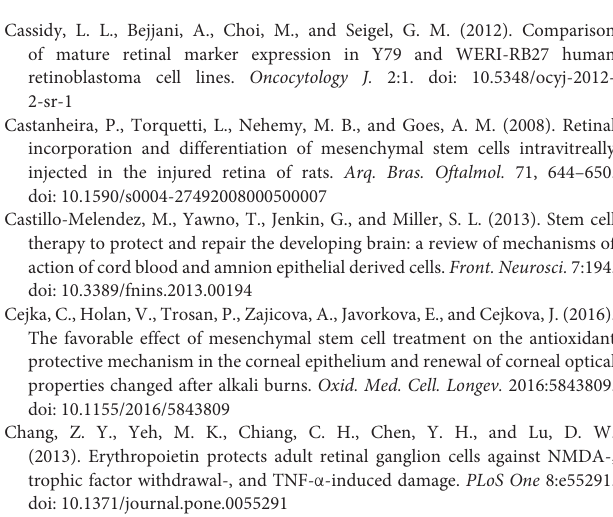
FIGURE S1 | Schematic representation of the third-generation system comprising the packaging mix and EPO -encoding lentiviral transfer vector (Ex-A1011-Lv183) constructs. (A) Vector map diagram for pReceiver-Lv183 lentiviral transfer plasmid encoding human erythropoietin ( EPO ) and enhanced gene-tagged green fluorescent protein ( GFP ). The self-inactivation of HIV-based lentiviral vector (Ex-A1011-Lv183) is a third-generation lentiviral vector containing the cis-active sequences of HIV-1 that are required for encapsidation of the viral vector genome and for viral transduction of target cells, as well as the C-terminal tagged GFP expression under the control of human cytomegalovirus (CMV) promoter. The upstream 5 (cid:48) LTR contains the rsv promoter to drive the production and expression of viral RNA in the packaging cells. The U3 enhancer sequences in the region of the 3 (cid:48) LTR are deleted to ensure self-inactivation of the lentiviral construct after transduction and integration into the genomic DNA of the target cells. (B) The HIV packaging mix contains two packaging plasmids, one encoding gag - pol , another encoding rev , and an envelope protein (Env) encodes vsv-g , to allow extensive infectivity. (C) Confirmation of EPO gene from pReceiver-Lv183 plasmid. Resulting plasmid DNA was electrophoresed on an agarose gel in the following lanes: lane 1 (100 base pairs DNA ladder), lane 2 (positive control containing 129 ng/ µ l of EPO -encoding lentiviral plasmid), lane 3 (negative control containing no EPO -encoding lentiviral plasmid), and lane 4 (containing 129 ng/ µ l of transformed EPO -encoding lentiviral plasmid). Bands were of the expected size, as shown in the schematic of the PCR products. FIGURE S2 | Lentiviral transfection of the human kidney (293FT) cell line with human erythropoietin ( EPO ) tagged with enhanced green fluorescent protein ( GFP ) at 12 h, 24 h, 48 h and 60 h post-transfection. (A) Phase contrast image of a healthy culture of 293FT cell line derived from primary embryonic human kidney cells. On day 7, the adherent cells were at 60%–70% cell confluence and had the appearance of epithelial-like cells in polygonal-shapes. (B–D) Morphological change in cultured cells after 12 h post-transfection with EPO -encoding lentiviral plasmid. (E–M) At 24 h, 48 h and 60 h, the appearance of large, multinucleated syncytia was observed across the cell culture. Expression of GFP was visualized using inverted fluorescence microscopy, indicating efficiency of transfection. Cells were imaged by phase contrast microscopy and inverted fluorescence microscopy. FIGURE S3 | Dose response curve of glutamate on Y79 retinal cell. A dose responsive assay on Y79 cells upon exposure to increasing concentrations of glutamate, GA (0–100 mM) for 24 h. The dose responsive effect of GA on Y79 retinal cell was applied as IC 50 value that representing the concentration of glutamate that is required to inhibit 50% of cell growth, in this experiment. Determination of the IC 50 was calculated by using the best-fit curve model analyzed with GraphPad Prism software. IC 50 of glutamate was estimated at 67.42 ± 0.31 mM (mean ± SEM; n =